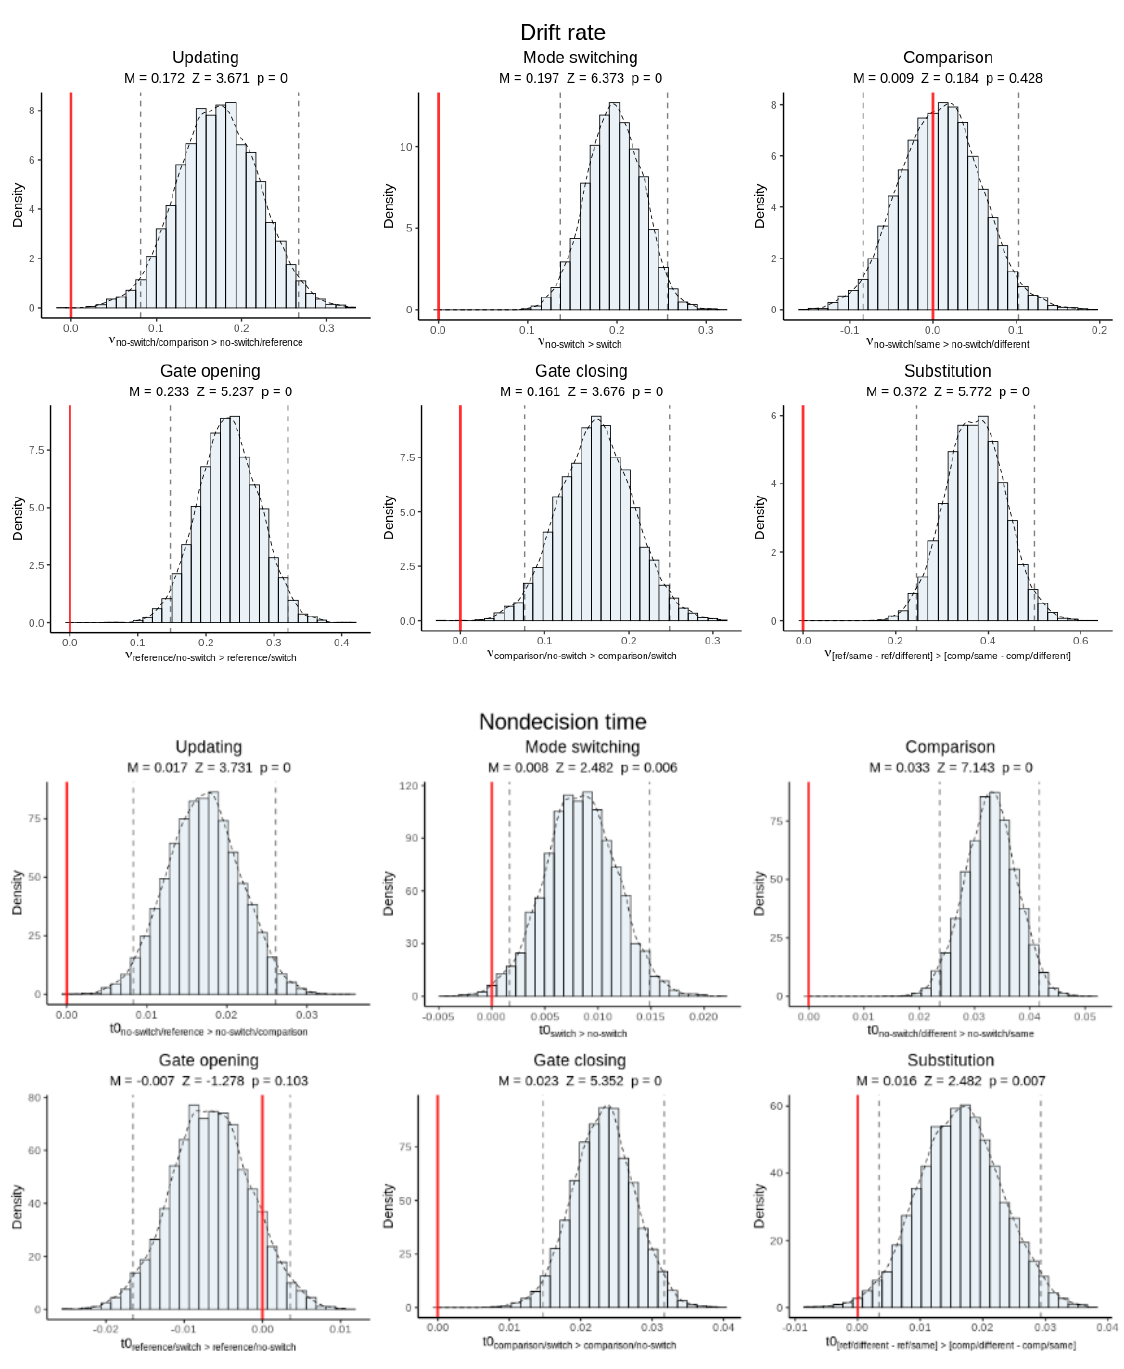
Figure 8. Posterior inference on canonical cost effects for hyper-mean drift rate ( top panels ) and non-decision time parameters ( bottom panels ). Each panel shows a histogram of the posterior distribution as well as the posterior mean, Z- score, and p -value of the effect. Dotted lines represent 95% credible intervals. Red lines indicate the zero point. Visually, if the red line appears outside of the credible interval, then the effect is significant. The x -axis labels state how the contrast is calculated.